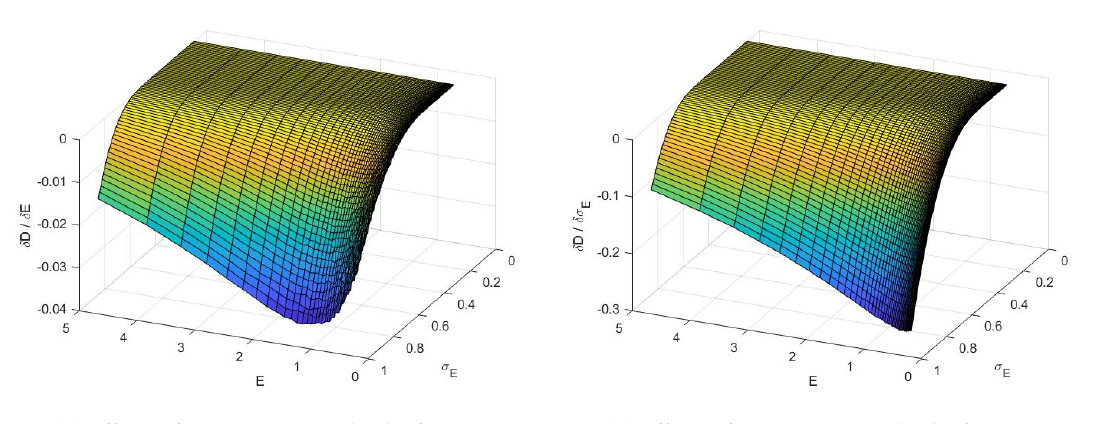
Figure 1. Effect on the Sensitivities of D . The left and right panels show the impact of a shock in equity and volatility of euqity (respectively) on the market value of the debt. The shock is applied on different touples of euqity and volatility of equity (from 0 to 5 for E and from 0 to 1 for σ E